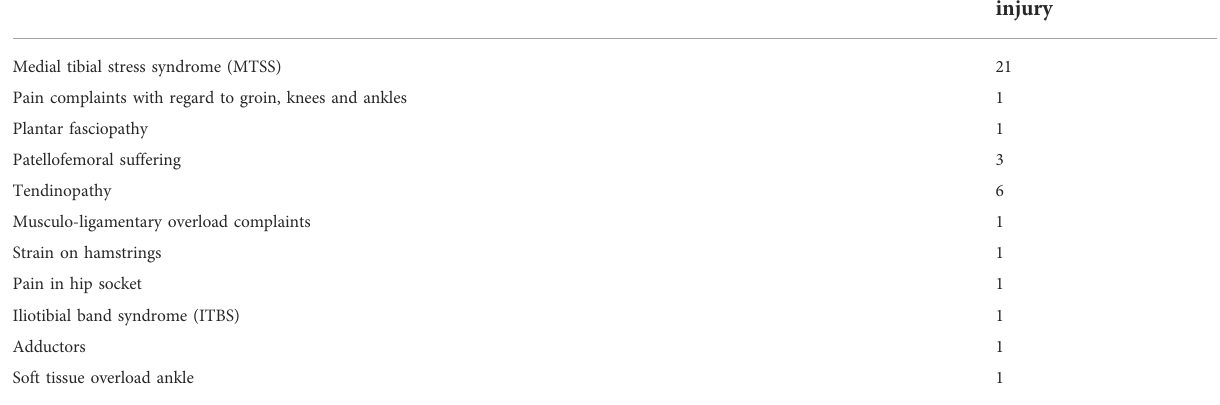
TABLE 2Numberof peoplesuffering fromaspeci fi clowerextremityoveruse injury.Note thatsome peoplehadmultipleinjuries, sothe totalnumber of injuries does not equal the total number of injured people. All people that had an unknown injury type, missing/incorrect values or an acute injury are omitted from this